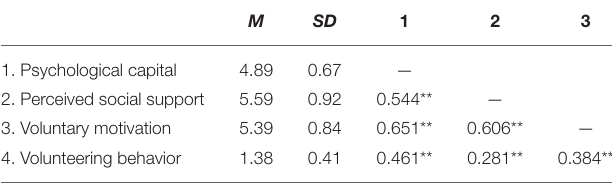
TABLE 1 | Means, standard deviations and correlation coefficients of variables. M SD